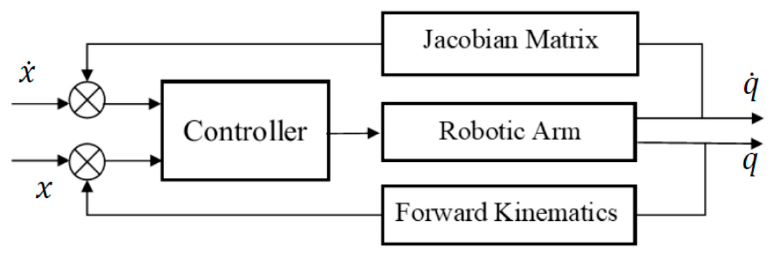
Figure 2. Block diagram for task space control.